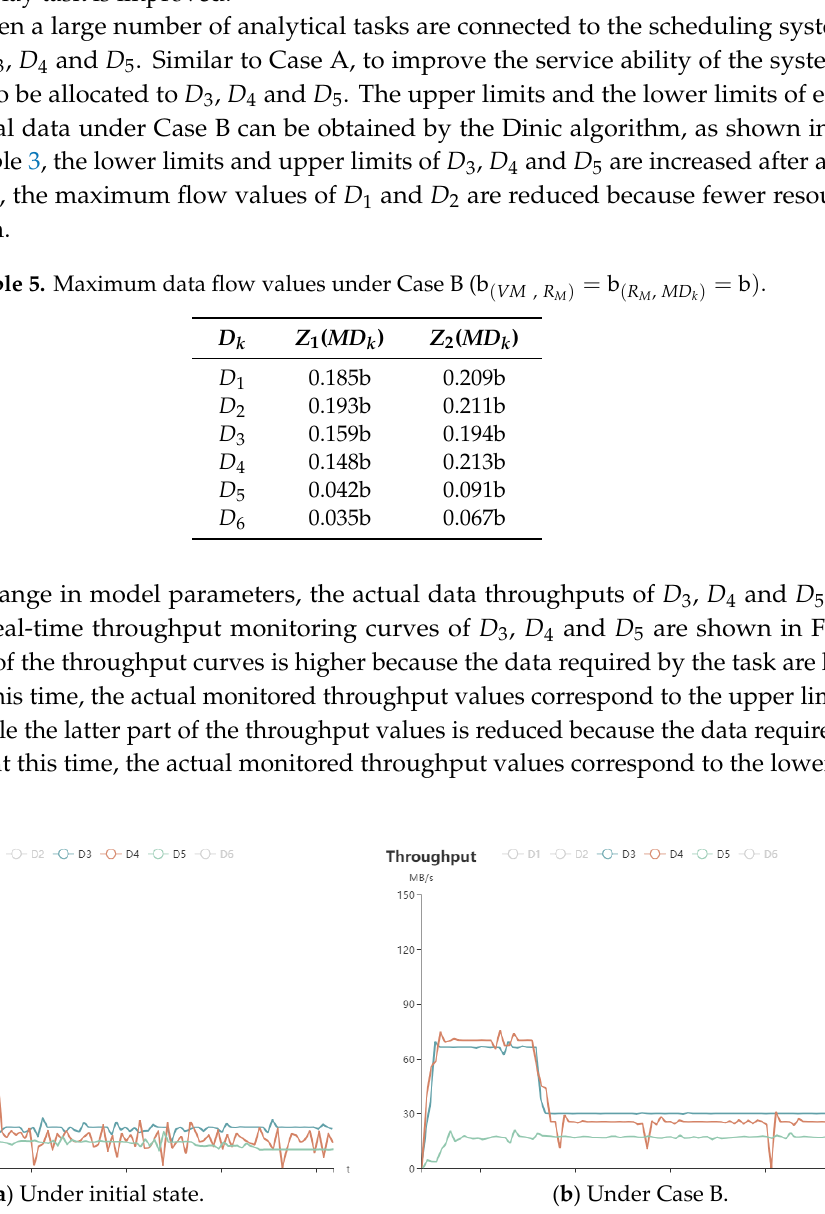
Figure 11. The real-time throughput monitoring curves of 𝐷 3 , 𝐷 4 and 𝐷 5 .